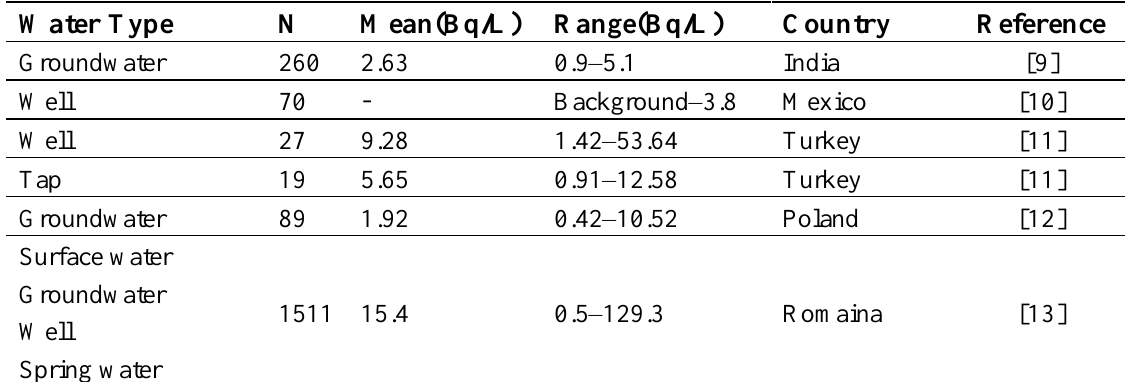
Table 2. Radon concentrations in various types of waters from other countries.